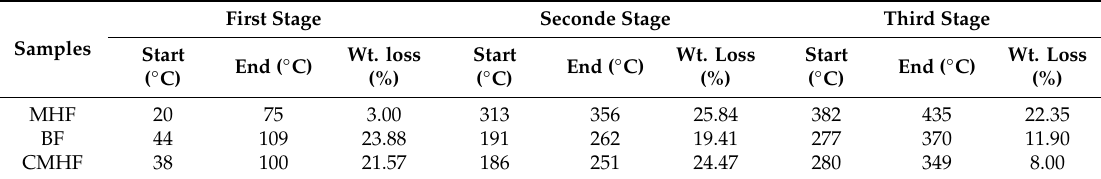
Figure 4. Thermal analysis. ( a ) Thermogravimetry (TGA) thermograms of MHF, BF, and CMHF; ( b ) Differential scanning calorimetry (DSC) thermograms of MHF, BF, and CMHF. Table 4. The thermal behavior of MHF and films determined by TGA.